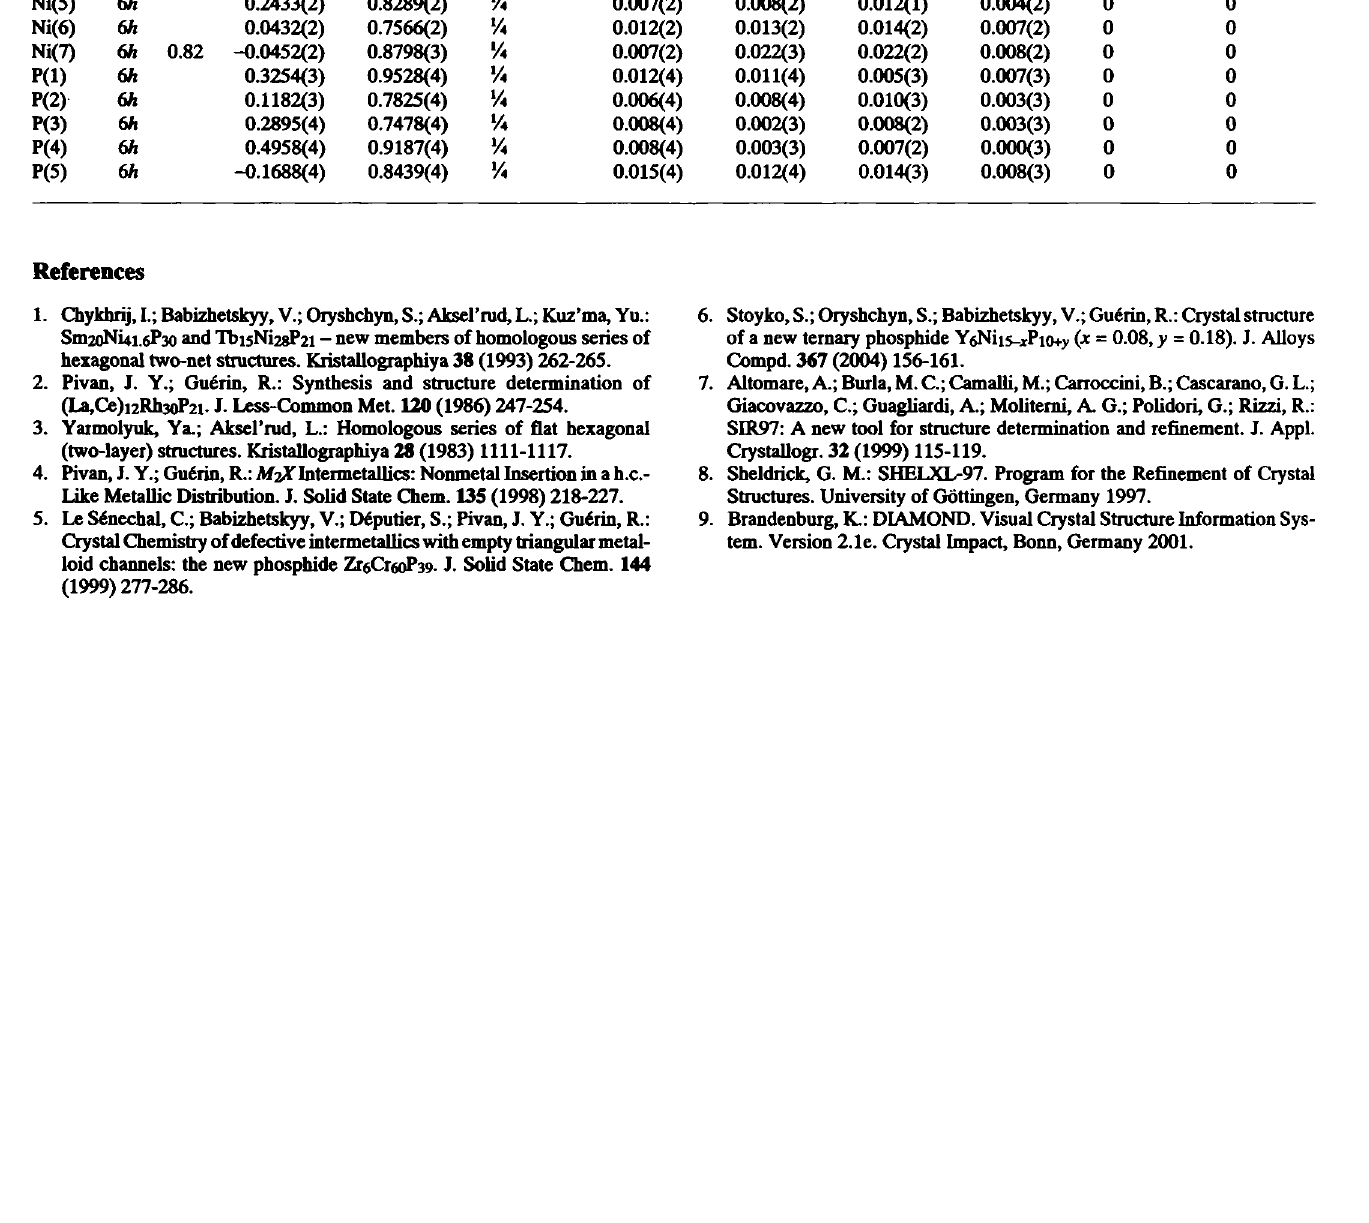
Table 3. Atomic coordinates and displacement parameters (in Ä 2